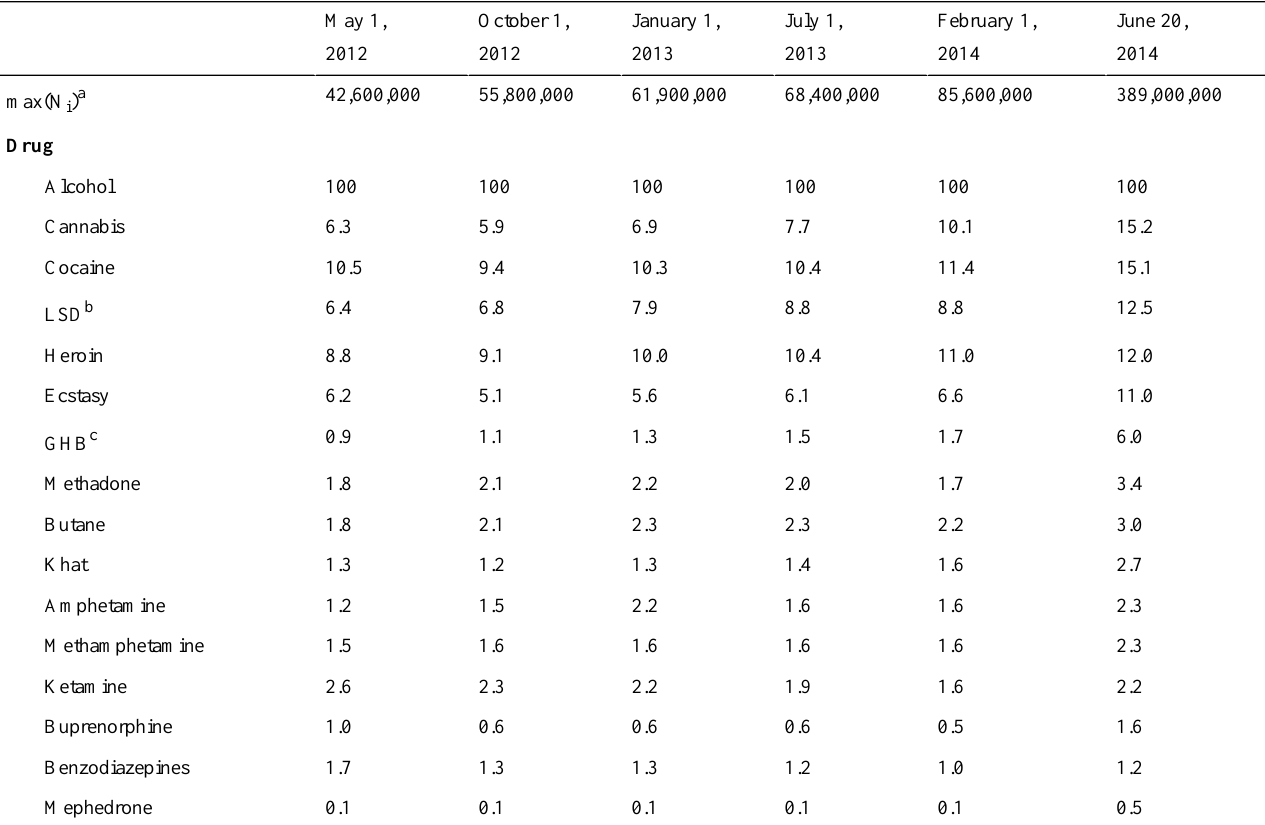
Table 2. Variation over time of relative popularity indexes (%) for drugs found by Google search, by